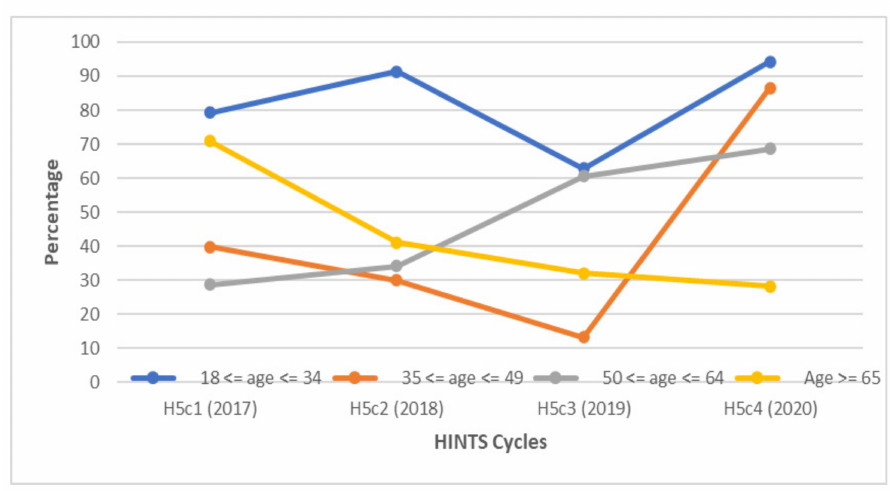
Figure 9. Awareness of the HPV vaccine among gay and bisexual males is illustrated according to specific age groups between 2017 and 2020. The highest percentage of GBM with knowledge about HPV over the entire study period were between the ages of 18 and 34. A gradual decline in HPV vaccine awareness was observed in GBM aged 65 and